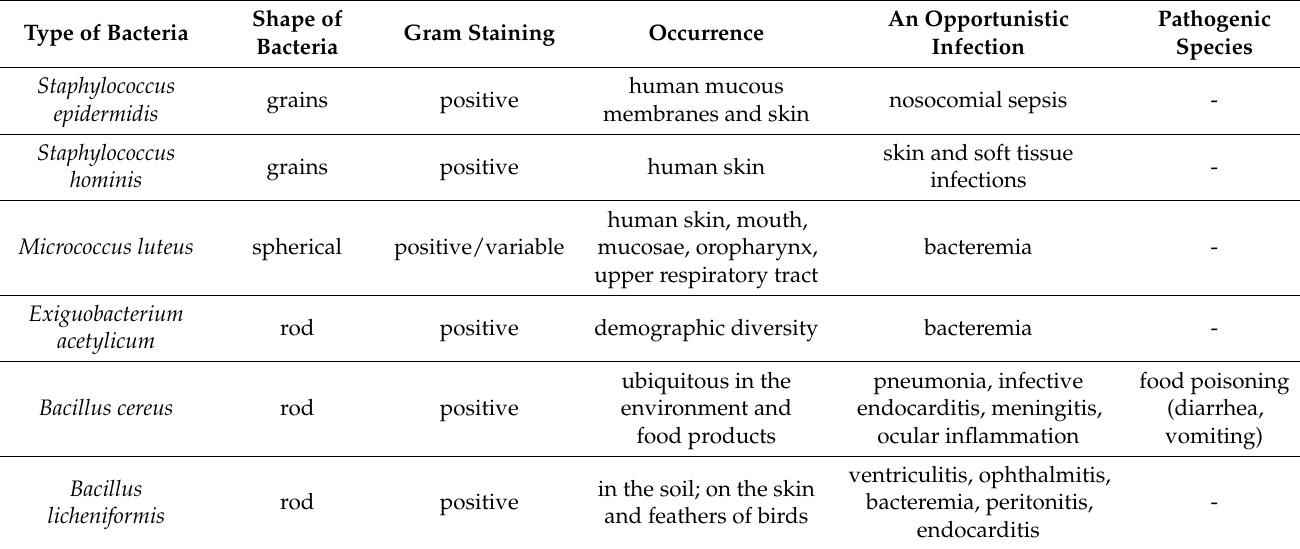
Table 1. Characteristics of types of bacteria prevalent in public